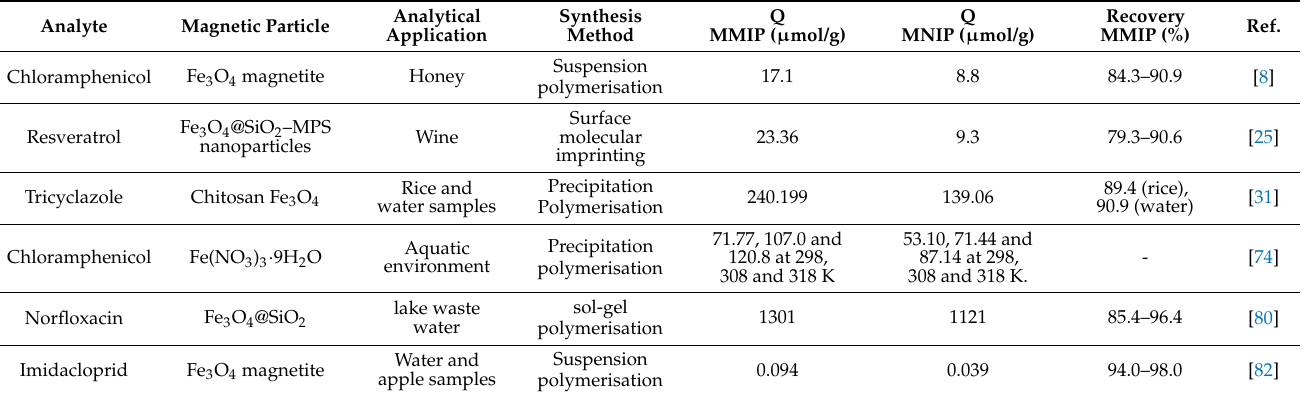
Table 2. Comparison of the analytical features of developed MMIP methods with previously reported methods using free radical polymerisation (FRP) and sol gel